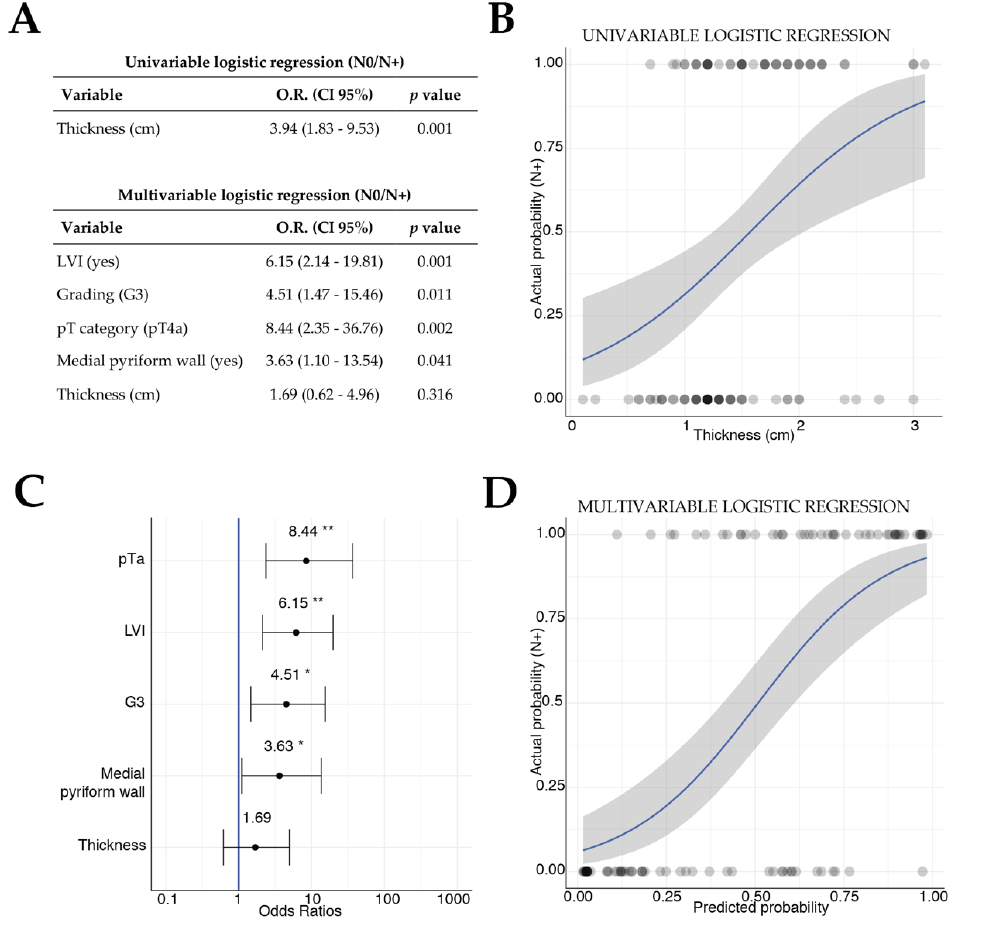
Figure 6. ( A ) Univariable logistic model including tumor thickness for the prediction of the N0 vs. N + status and the multivariable one by stepwise variables selection. ( B ) Logistic function of the univariable logistic model including tumor thickness as covariate. ( C ) Forest plot of odds ratios and 95% CI of the multivariable logistic model for N status prediction. ( D ) Logistic function of the predicted probability in the multivariable logistic model against the actual probability of being N0 vs. N + . For logistic functions, 95% CI is showed with gray filling.